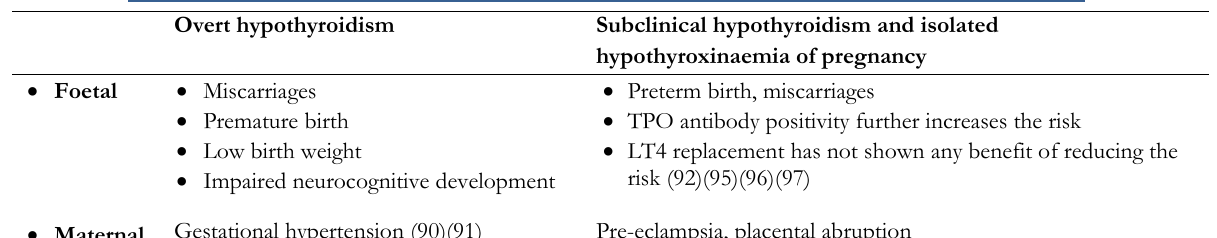
Table 4.2. Adverse foetal and maternal consequences of hypothyroidism in